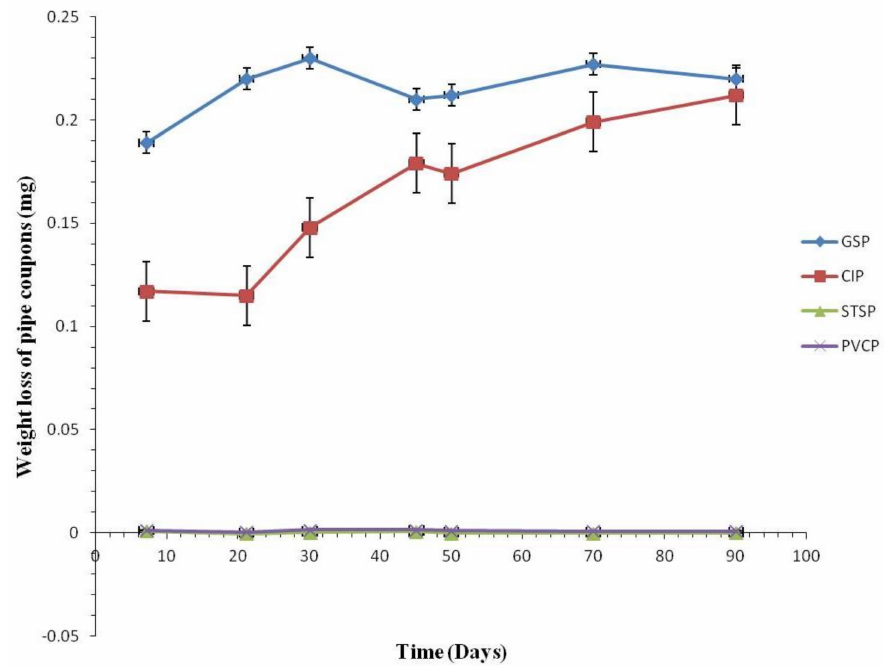
Figure 12. Weight loss of coupons with TW in galvanized steel, cast iron, stainless steel, and polyvinyl chloride pipes over time with standard error